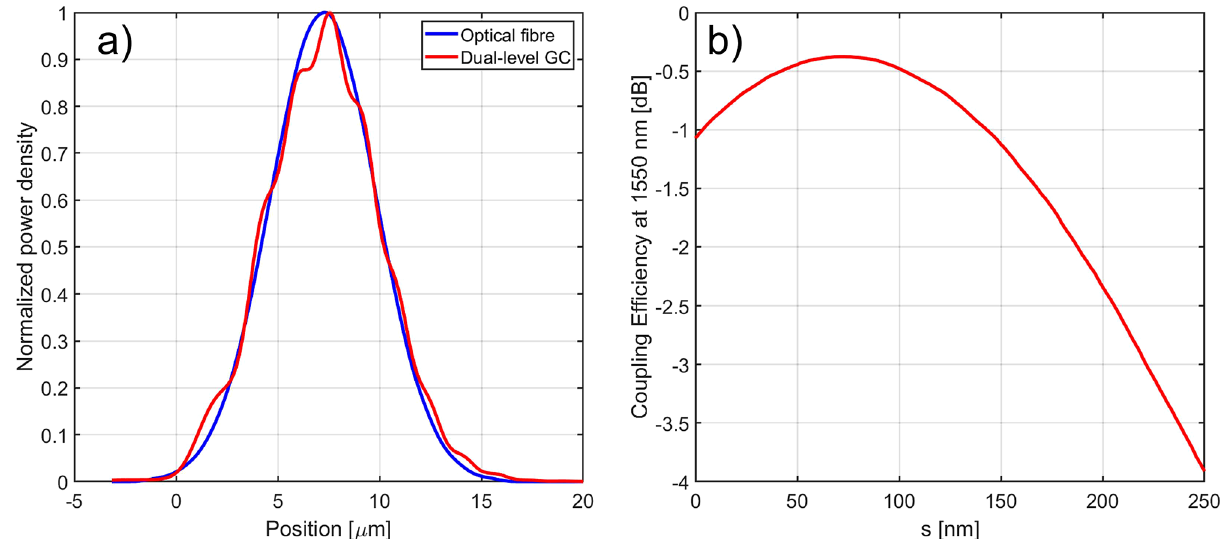
Figure 4. ( a ) Comparison of the normalized power density profiles of the optical fibre mode and of the diffracted mode from the dual-level Si–Si 3 N 4 GC with 400 nm thick Si 3 N 4 waveguide; ( b ) numerically simulated CE at 1550 nm as a function of the separation s between the two layers for the dual-level Si–Si 3 N 4 GC with 400 nm thick Si 3 N 4 waveguide. All the parameters used for these simulations are listed in Table 2 (table row with θ = 2 ◦